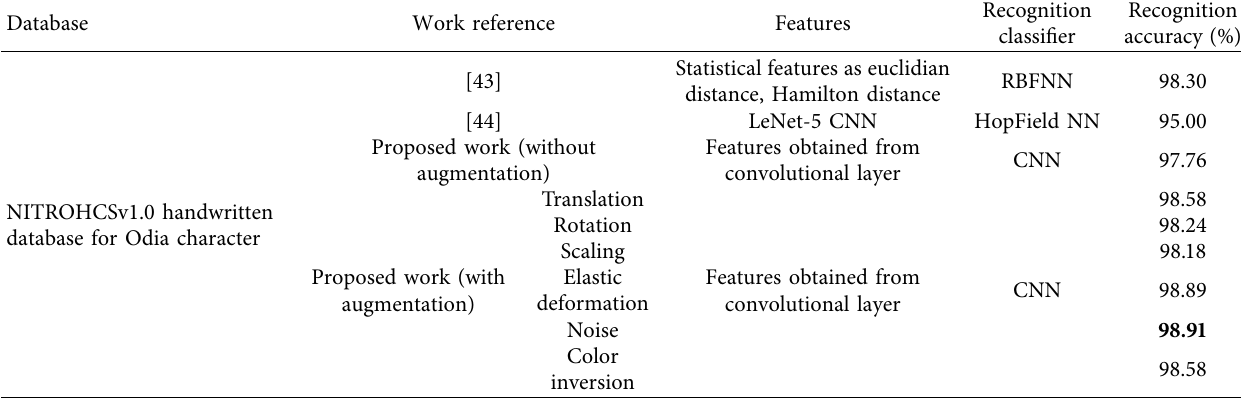
Table 11: Performance comparison on handwritten NITROHCS v1.0 Odia character databases.